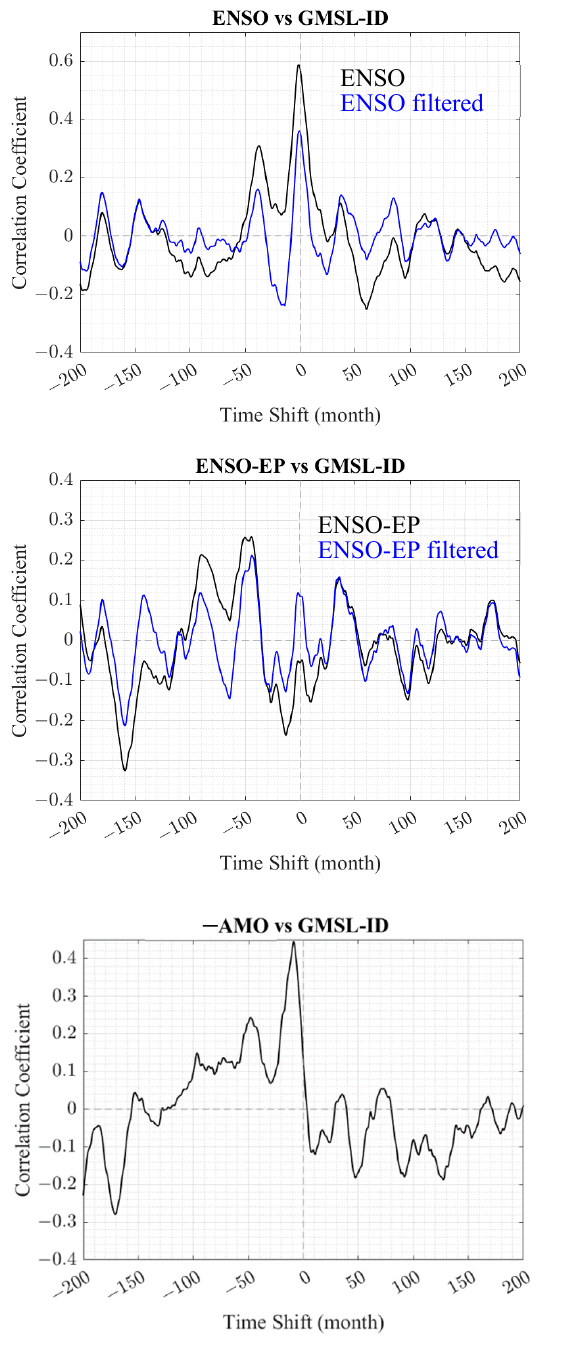
Figure 3. Time-domain cross-correlation functions of GMSL-ID ( t ) with respect to the indices of the five climatic oscillations (unfiltered and filtered versions; ENSO further separated into the CP- and EP- types) in Figure 2, as functions of relative time shift (in months), where positive time shift means the oscillation leading GMSL-ID ( t ) in phase